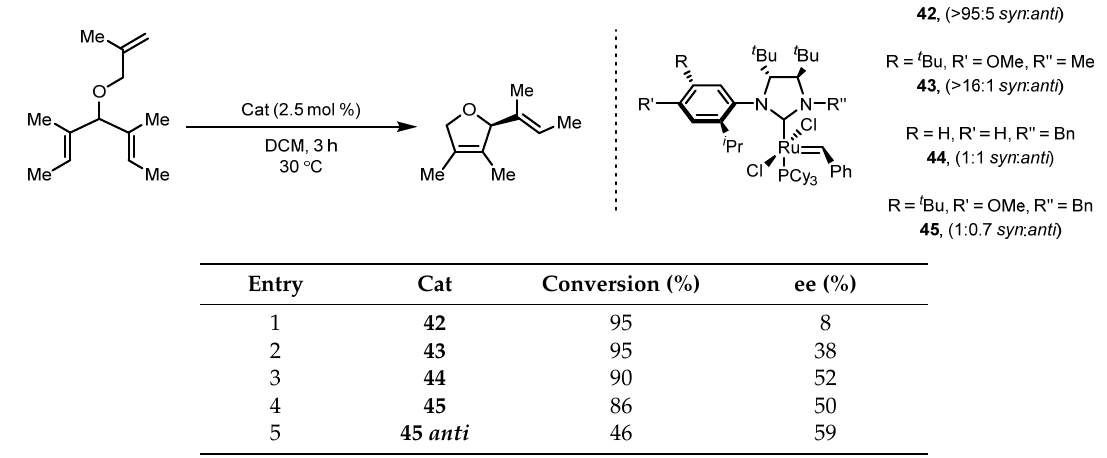
Table 12. Asymmetric ring-closing metathesis (ARCM) to form tetrasubstituted olefins using unsymmetrical N -heterocyclic carbene (NHC) ligands.